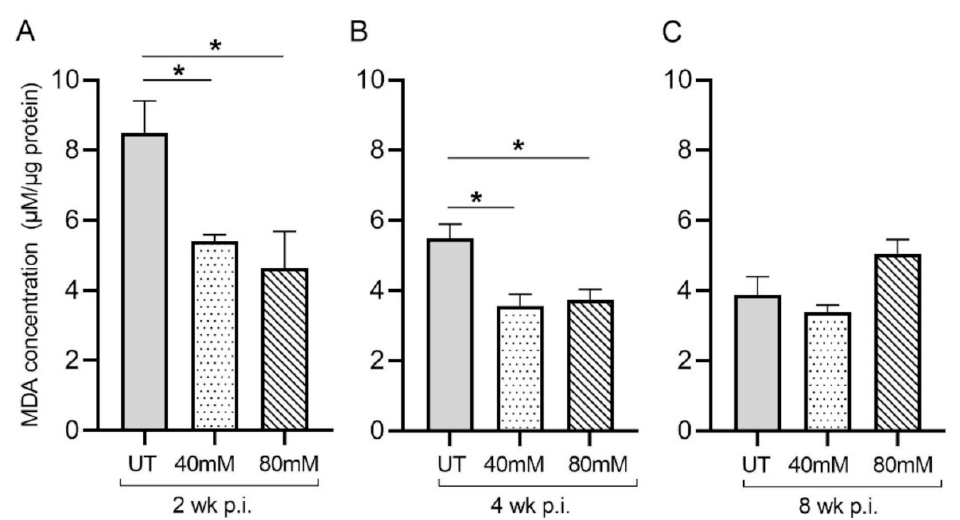
Figure 2. L-GSH treatment significantly reduced the malondialdehyde (MDA) levels in the lungs of M. tb -infected mice at 2 weeks and 4 weeks post-infection. The MDA levels in the lung lysates of untreated (UT) or 40 mM or 80 mM L-GSH-treated M. tb -infected mice were measured spec- trophotometrically. The lung lysates were collected from the untreated mice and mice treated with 40 mM or 80 mM L-GSH at 2 weeks ( A ), 4 weeks ( B ), and 8 weeks ( C ) post-infection (p.i.). All of the values plotted for each group represent the mean values +/ − standard deviation. One-way ANOVA with Tukey’s multiple group post correction was applied to determine the significance between groups, and a p -value of <0.05 (*) was considered significant. Statistical analysis was performed using GraphPad Prism Software 8. The sample size is 6 mice (n = 6) per group, per time point.